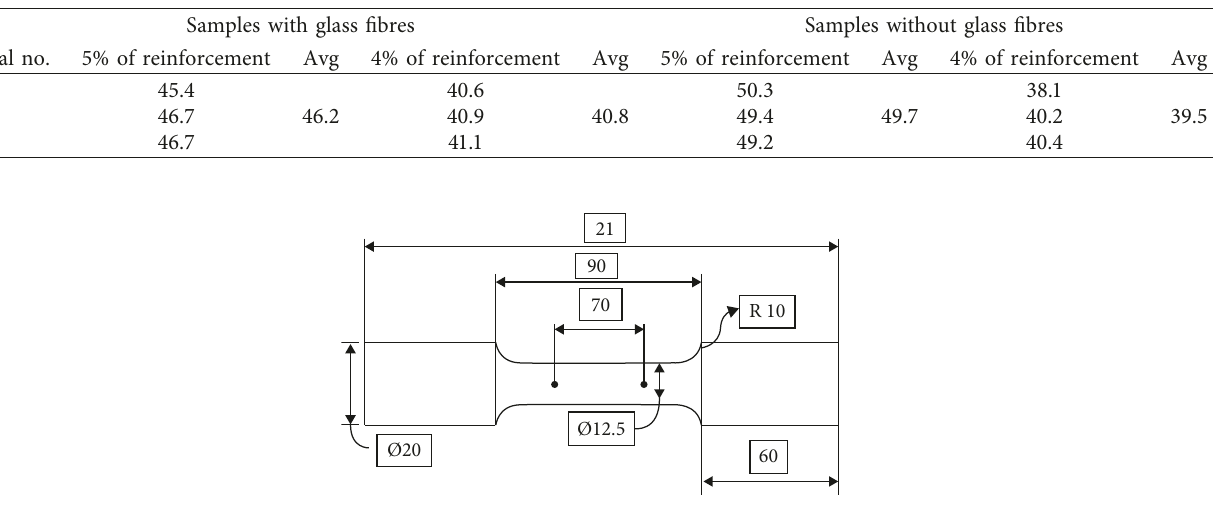
Figure 2: Dimensions of tensile test specimen. (ASTM E8 standard).